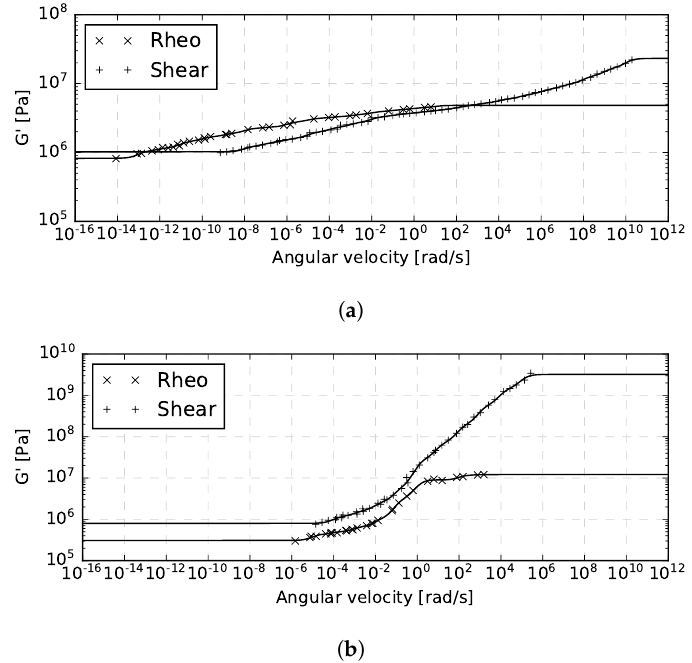
Figure 14. Representative master curves constructed at 20 ◦ C with both experimental methods: ( a ) EVA interlayer, ( b ) PVB interlayer; rheo indicates the dynamic torsion test, shear indicates the single-lap shear